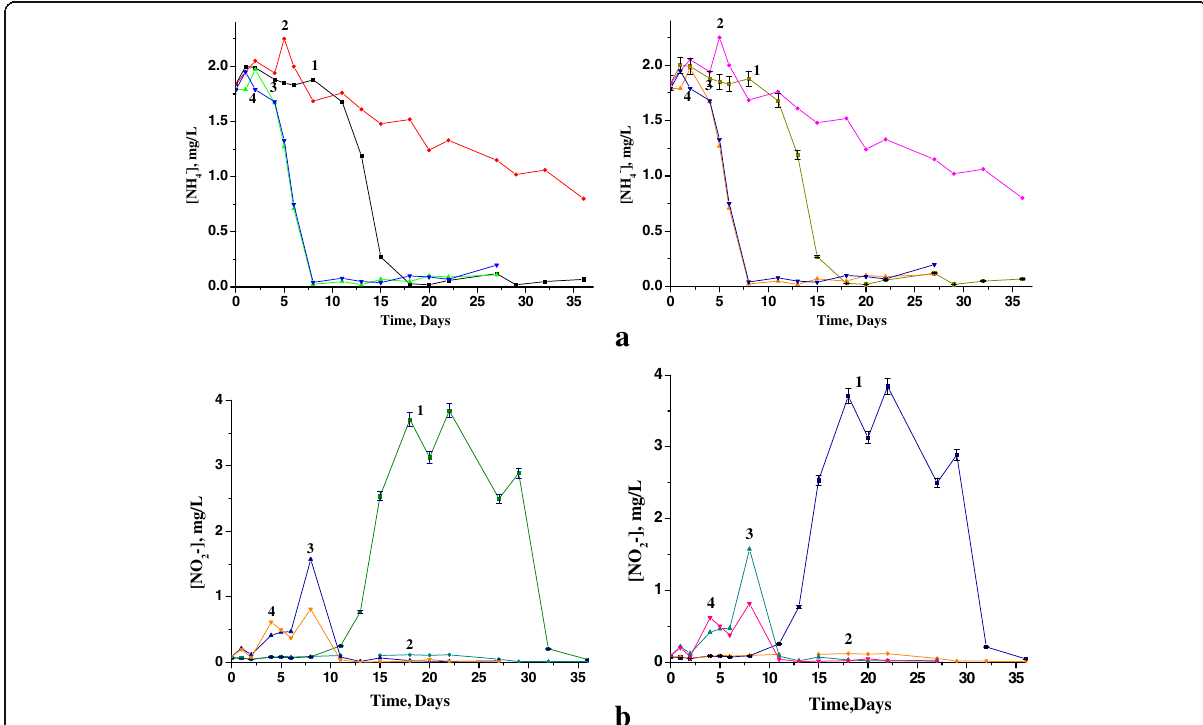
Fig. 1 Dynamics of ammonium ( a ) and nitrite ( b ) ion concentrations in the Nistru River (Spataru et al. 2015). 1 — Nistru River, Varancau village. 2 — Nistru River, Varancau village + CaCO 3 — Cunicea village, small river. 4 — Cunicea village, small river + CaCO 3 .